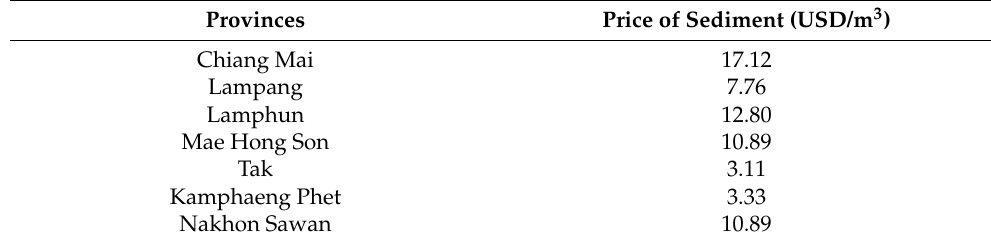
Table 3. Sediment price for each province